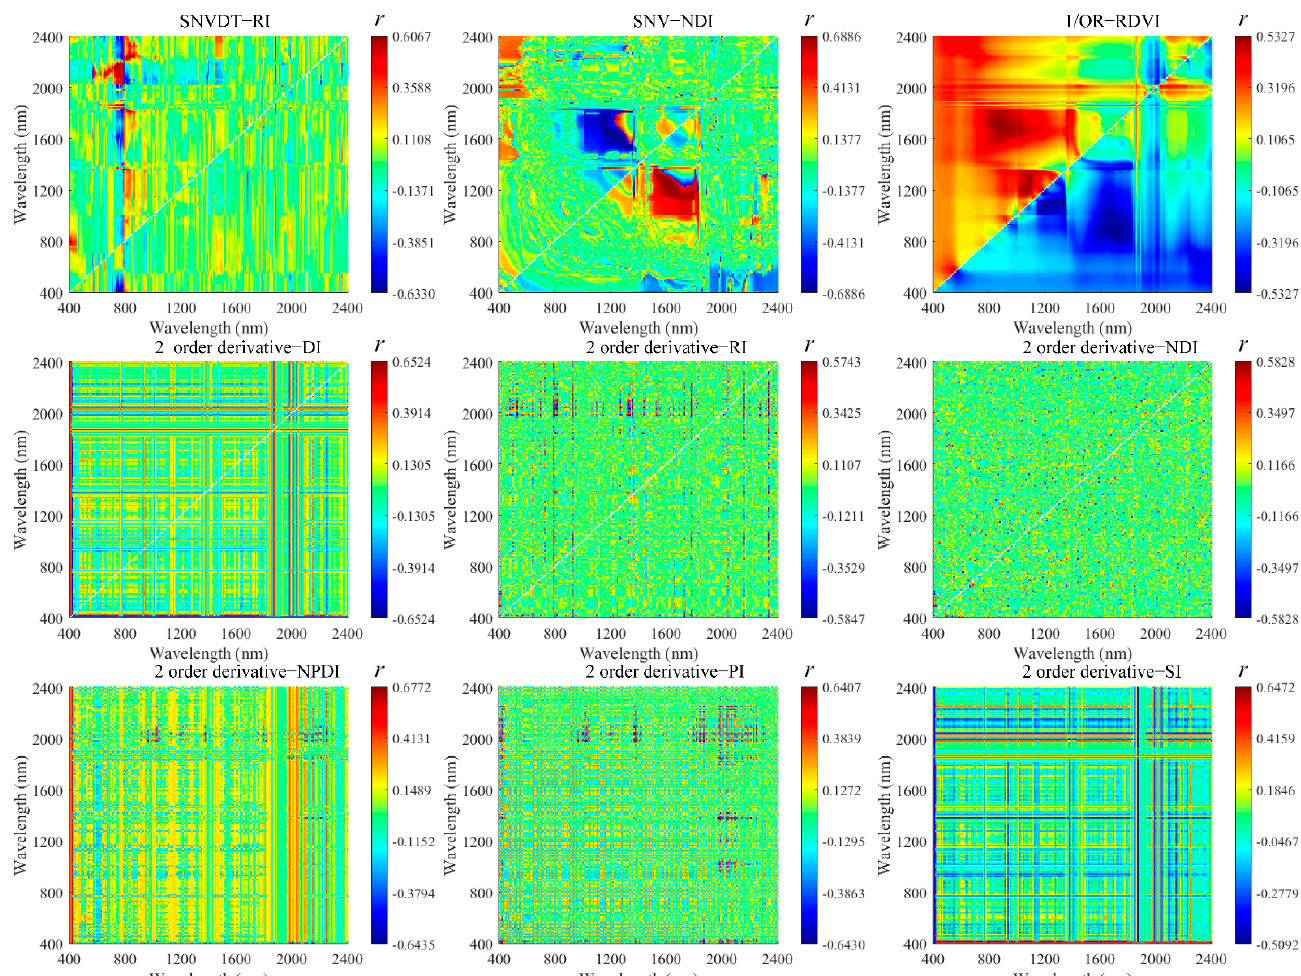
Figure 5. Maximum absolute correlation coefficient (MACC) of visible-near-infrared (Vis-NIR) ( a ) and two-band index ( b ) under different reflectance conversion modes.